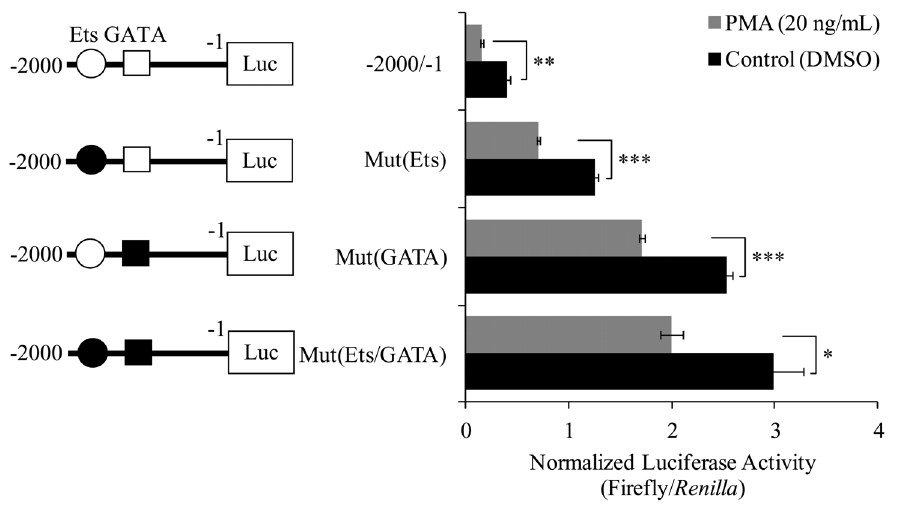
Figure 8. Effect of PMA on the activity of wild-type, Ets-mutated, GATA-mutated, and Ets/GATA mutated ck b promoter constructs. Each bar represents the mean ¡ SEM of triplicate samples from three independent experiments. (* p , 0.05, ** p , 0.01, and *** p , 0.001 vs. DMSO